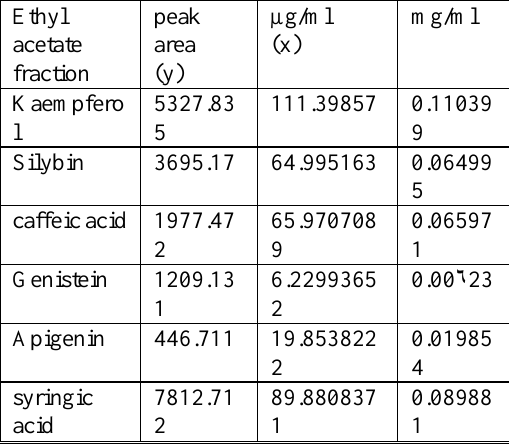
Table 4. The HPLC Quantitative analysis for Ethyl acetate